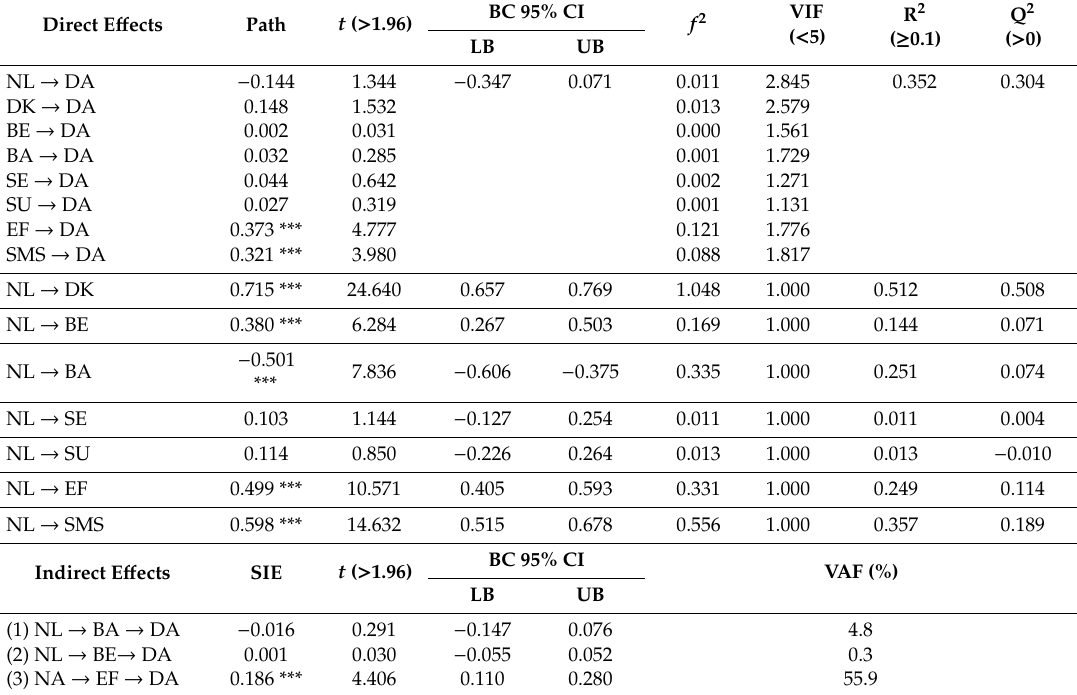
Table 4. Bootstrapping Result for Direct and Indirect E ff ects ( n =